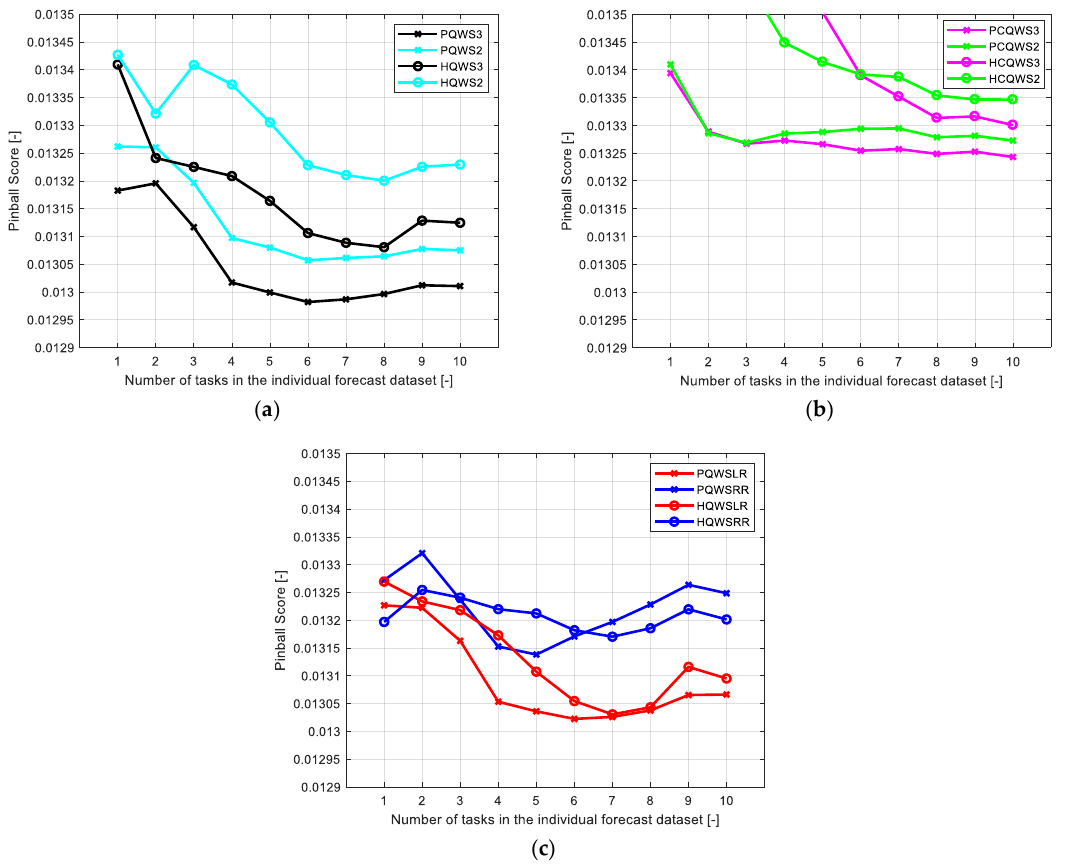
Figure 7. Pinball Score values of combined forecasts for the zone 3: ( a ) PQWS2, PQWS3, HQWS2, and HQWS3 approaches; ( b ) PCQWS2, PCQWS3, HCQWS2, HCQWS3 approaches; ( c ) PQWSLR, HQWSLR, PQWSRR, HQWSRR approaches.